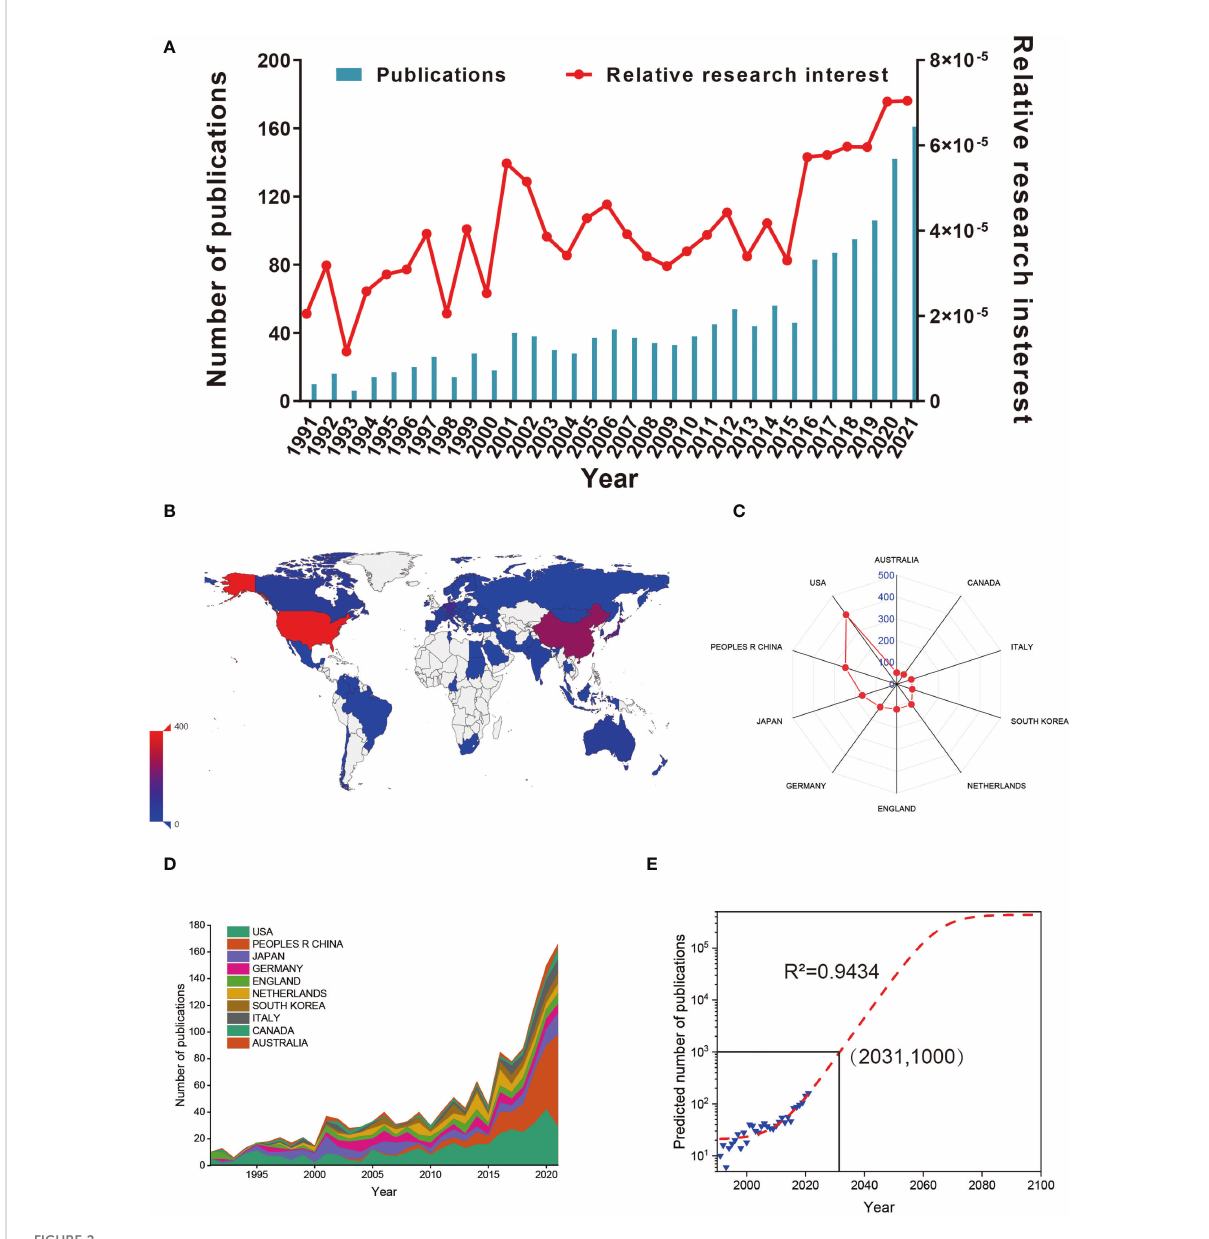
FIGURE 2 (A) The global number (blue bars) and relative research interests (red curve) of publications related to macrophages associated with osteoarthritis. (B) Distribution of macrophages associated with osteoarthritis research in world map. (C) The sum of publications related to macrophages associated with osteoarthritis from the top 10 countries and regions. (D) The annual number of publications in the top 10 most productive countries from 1991 to 2021. (E) Model fi tting curves of global trends in publications related to macrophages associated with osteoarthritis per year (R 2 = 0.9434, (2031,1000) indicates that the total publications will up to 1000 in year of